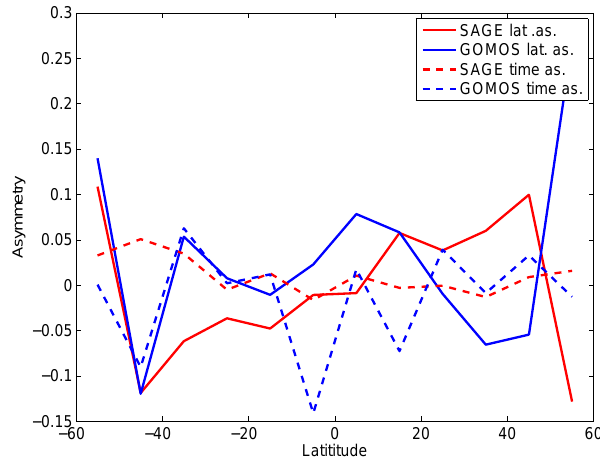
Fig. 6. The mean latitudinal and temporal asymmetries as a function of